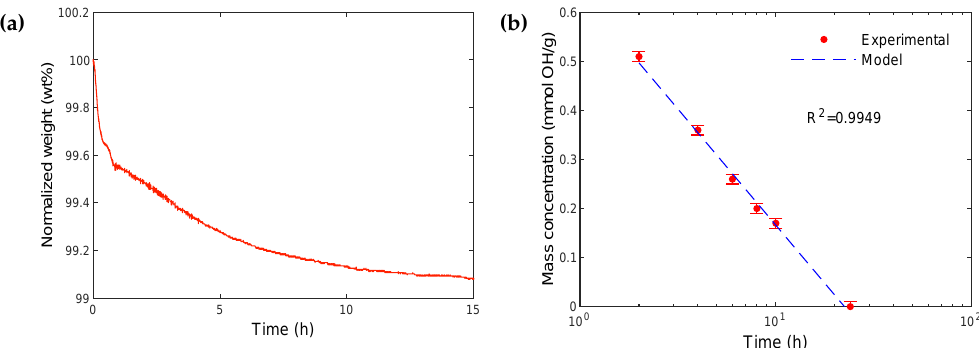
Figure 3. ( a ) TGA thermogram showing the normalized weight of fully rehydroxylated particles heated and maintained at 450 ◦ C for 24 h. The mass loss corresponds to the total value of the desorption of physically adsorbed water and dehydroxylation processes. The mass loss related to physically adsorbed water is subtracted from the total mass loss to determine the amount related to the dehydroxylation process, in order to obtain the hydroxyl groups’ surface density. ( b ) Evolution of the hydroxyl group mass concentration as a function of calcination time, for the fully rehydroxylated particles (logarithmic scale). The dotted blue line is a linear